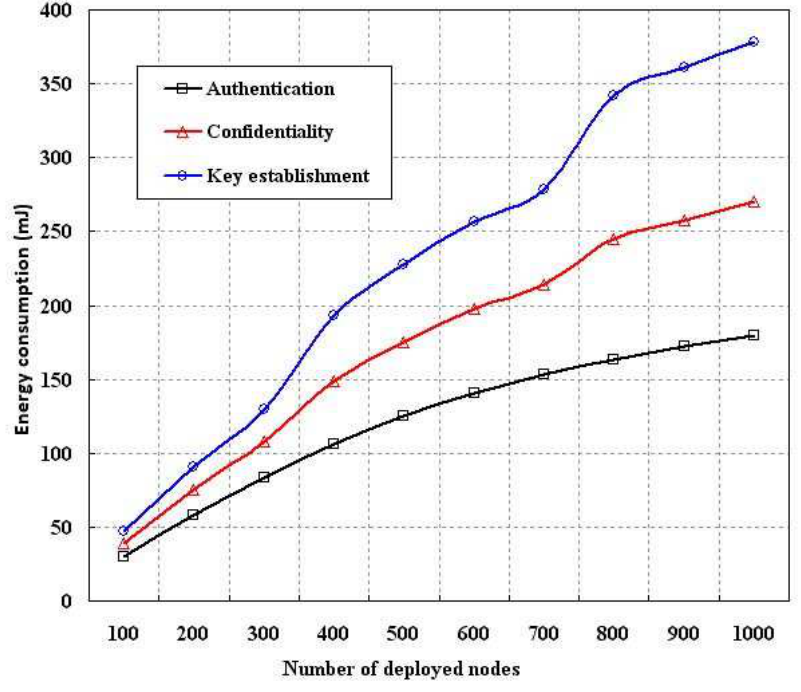
Figure 6. Evaluation of energy consumption with different number of nodes.